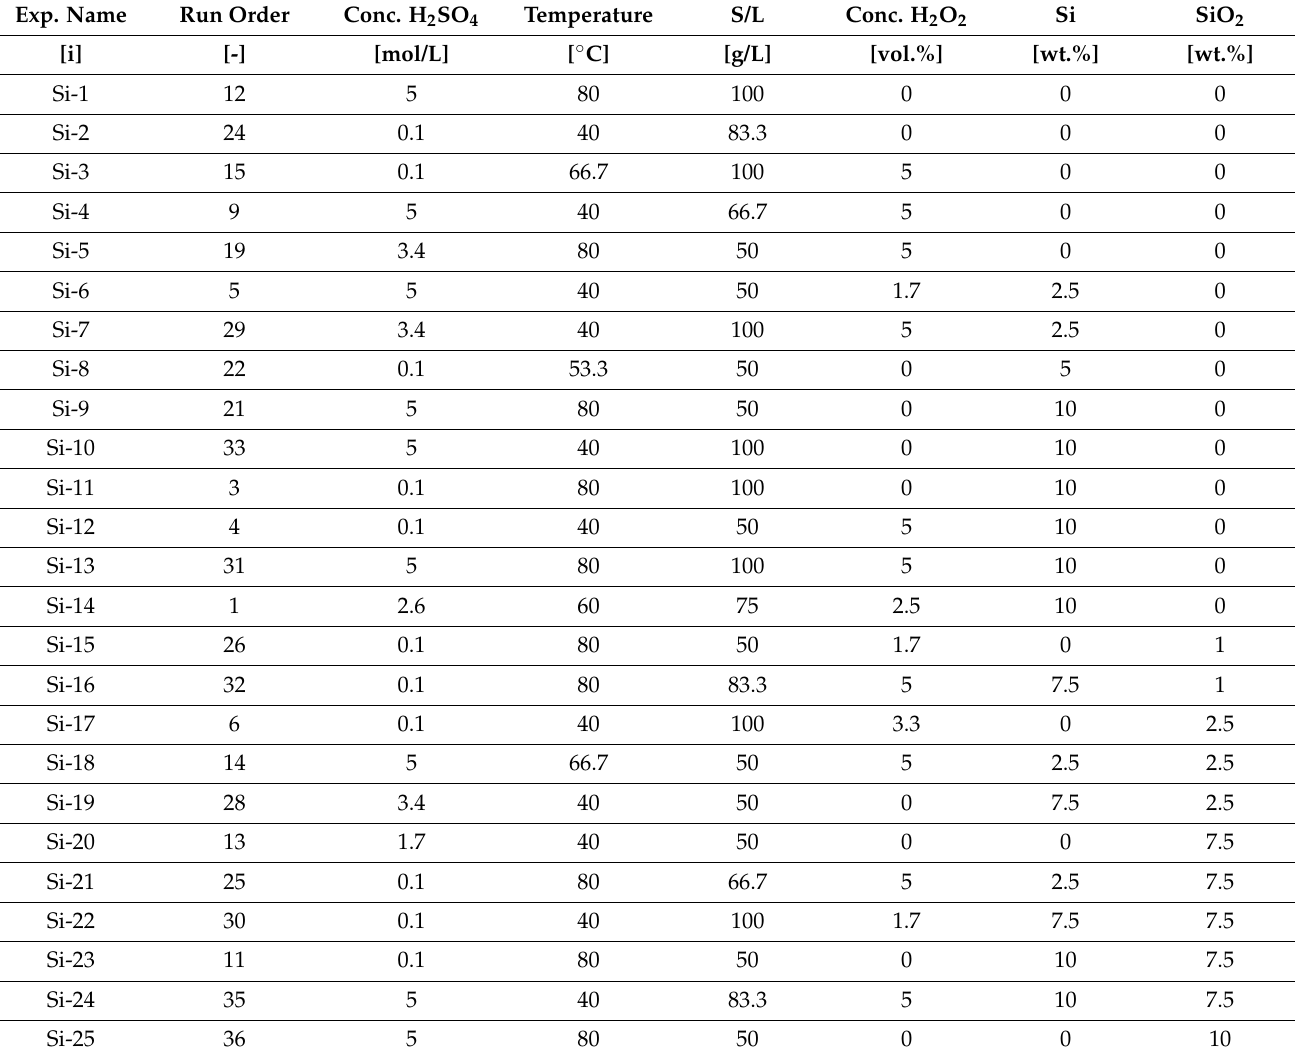
Table 1. D-optimal design matrix for the conducted experiments with addition of Si metal and/or SiO 2